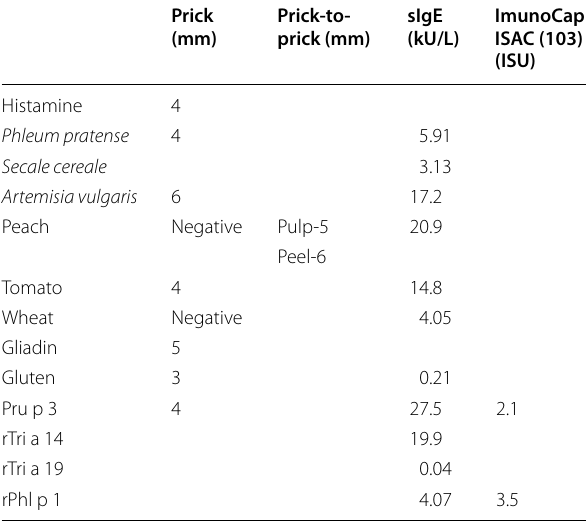
Table 1 Results of the investigation